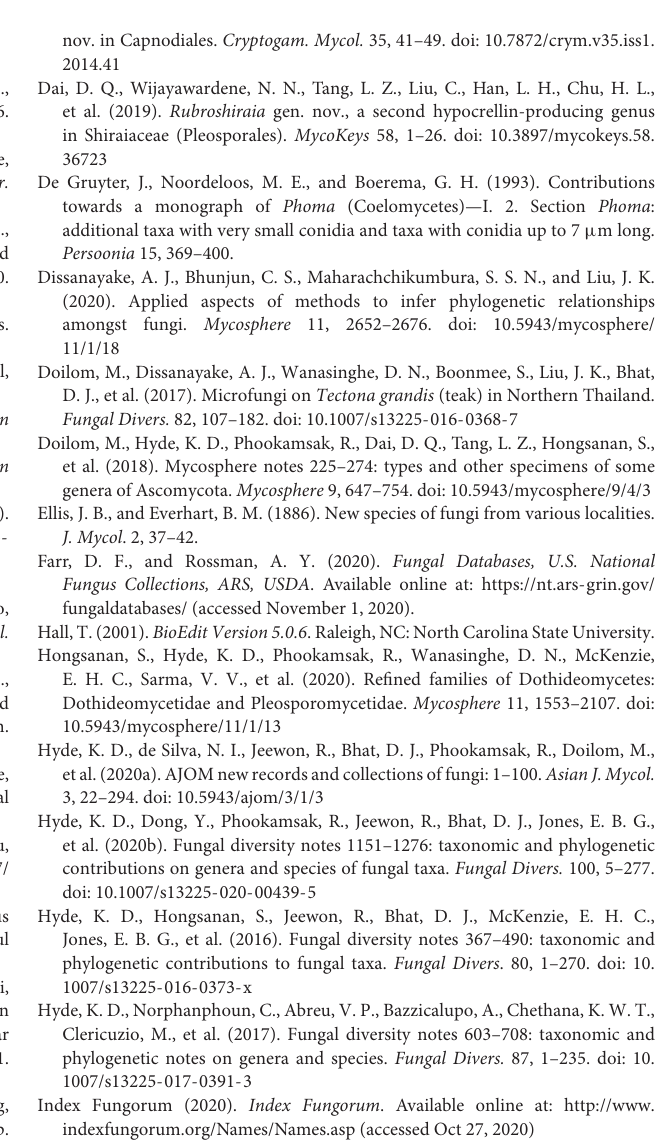
Supplementary Figure 1 | RAxML tree based on ITS, LSU and TEF1- α sequence matrix represented the phylogenetic relationships of taxa in Dictyosporiaceae. The tree is rooted to Periconia igniaria (CBS 845.96 and CBS 379.86). Bootstrap support values for ML are indicated above the nodes. Ex-type strains are in black bold and the new species and new combinations are indicated in blue bold. Supplementary Figure 2 | Phylogram generated by Bayesian inference (BI) analysis based on a combined ITS, LSU, SSU and TEF1- α sequence matrix represented the phylogenetic relationships of taxa in Dictyosporiaceae. The tree is rooted to Periconia igniaria (CBS 845.96 and CBS 379.86). Bayesian posterior probabilities are indicated above the nodes. Ex-type strains are in black bold and the new species and new combinations are indicated in blue bold. Supplementary Figure 3 | RAxML tree based on LSU, SSU, TEF1- α , RPB2 and ITS sequence matrix represented the phylogenetic relationships of Immotthia in Dictyosporiaceae with other families in Pleosporales. The tree is rooted to Capondium coffeae (CBS 147.52). Bootstrap support values for ML are indicated above the nodes. The placement of Immotthia in Dictyosporiaceae is indicated by yellow